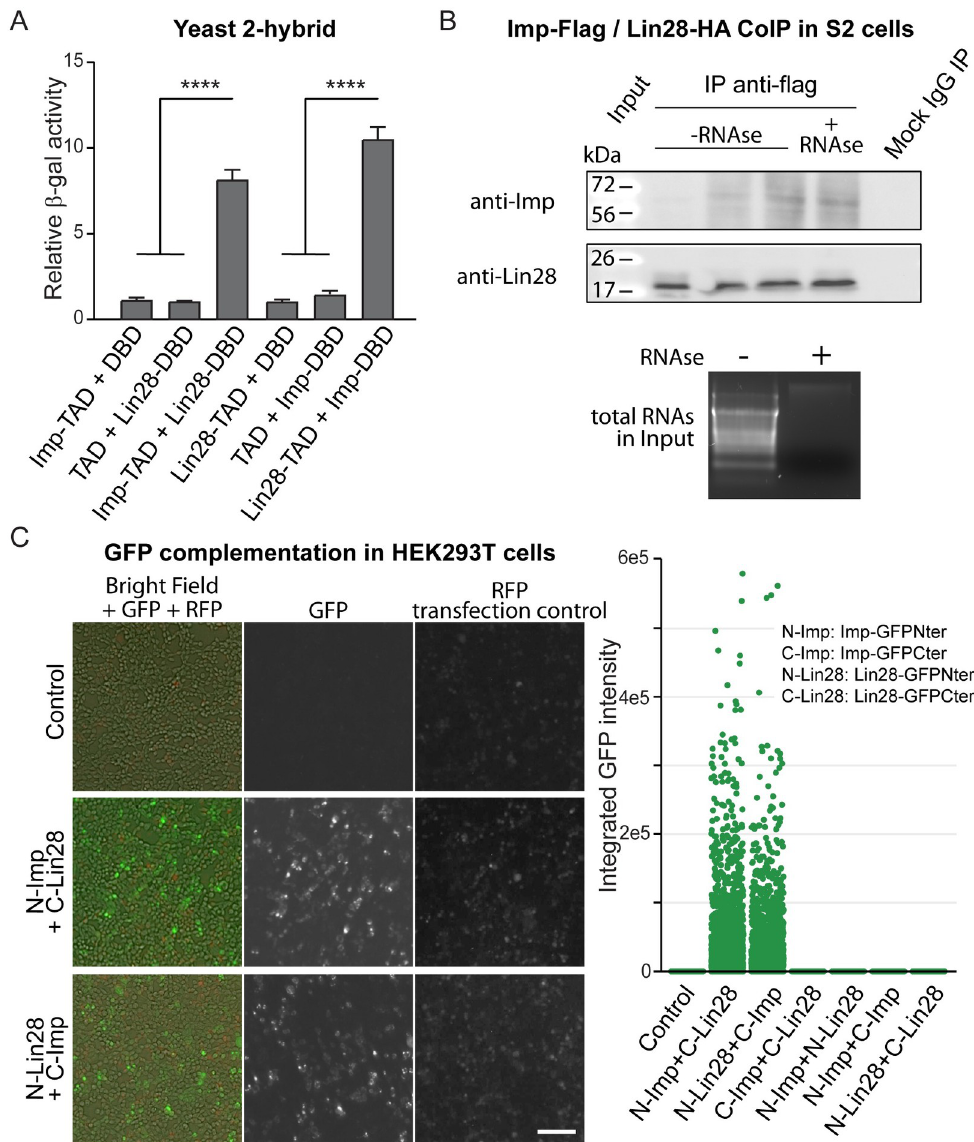
Fig 5. Drosophila Imp and Lin28 physically interact. (A) Imp and Lin28 can form a stable complex in yeast cells, as shown by 2-hybrid assay. Quantification of the β -galactosidase activity when Imp and Lin28 protein fusion with the Gal4 Transcriptional Activation Domain (TAD) or the LexA DNA Binding Domain (DBD). Significant reporter activity is detected only when the Imp-TAD+Lin28-DBD or Imp-DBD+Lin28-TAD protein combinations are expressed. Student’s t-test ���� p-value = < 0.0001. (B) Co-immunoprecipitation of HA-tagged Lin28 and FLAG-tagged Imp proteins expressed in cultured Drosophila S2 cells. Anti-Flag precipitation pulls-down both protein fusions. RNase treatment of the lysate does not affect the stability of the complex. Total RNAs stained with ethidium bromide demonstrate the efficacy of the RNase treatment. (C) Fluorescence images of GFP complementation assay in HEK293T cells show that only when the appropriate combinations of Lin28 and Imp protein fusions (GFP-ImpNter+Lin28-GFPCter or GFP-ImpCter +Lin28-GFPNter) result in significant GFP fluorescence. Quantification of the integrated GFP intensity in different combinations of Imp and Lin28 proteins is shown over hundreds of cells per condition. RFP expression serve as a transfection control and for normalization. Scale bar: 10 μ m.